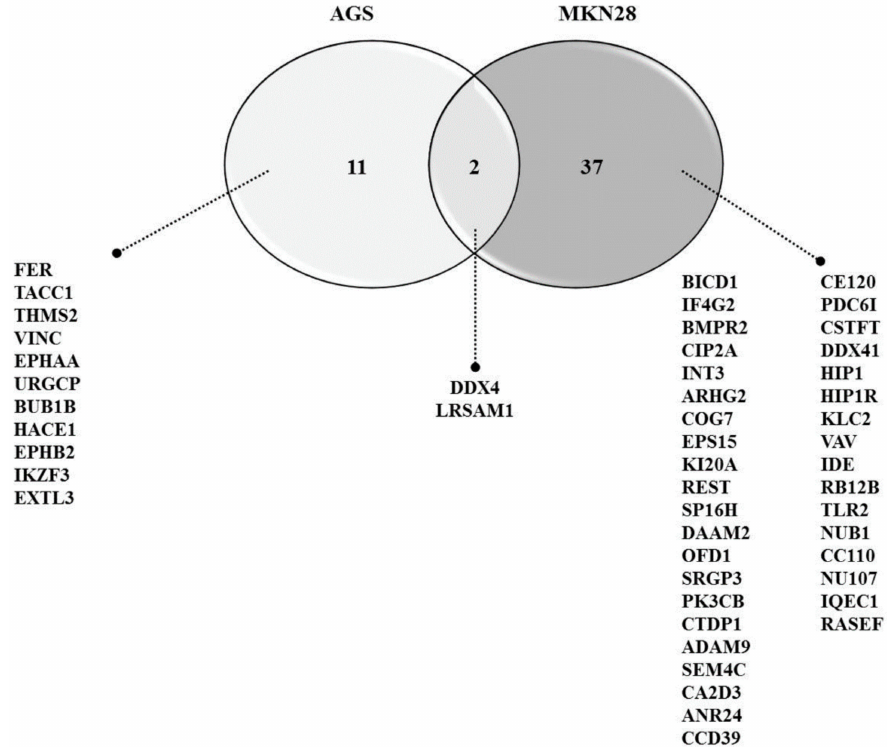
Figure 4. Venn diagram of differentially expressed proteins that are overlapped between AGS and MKN28 cells. A two-way Venn of AGS and MKN28 reveals two proteins that were commonly identified (DDX4, LRSAM1), while 11 and 37 proteins were uniquely identified in AGS and MKN28